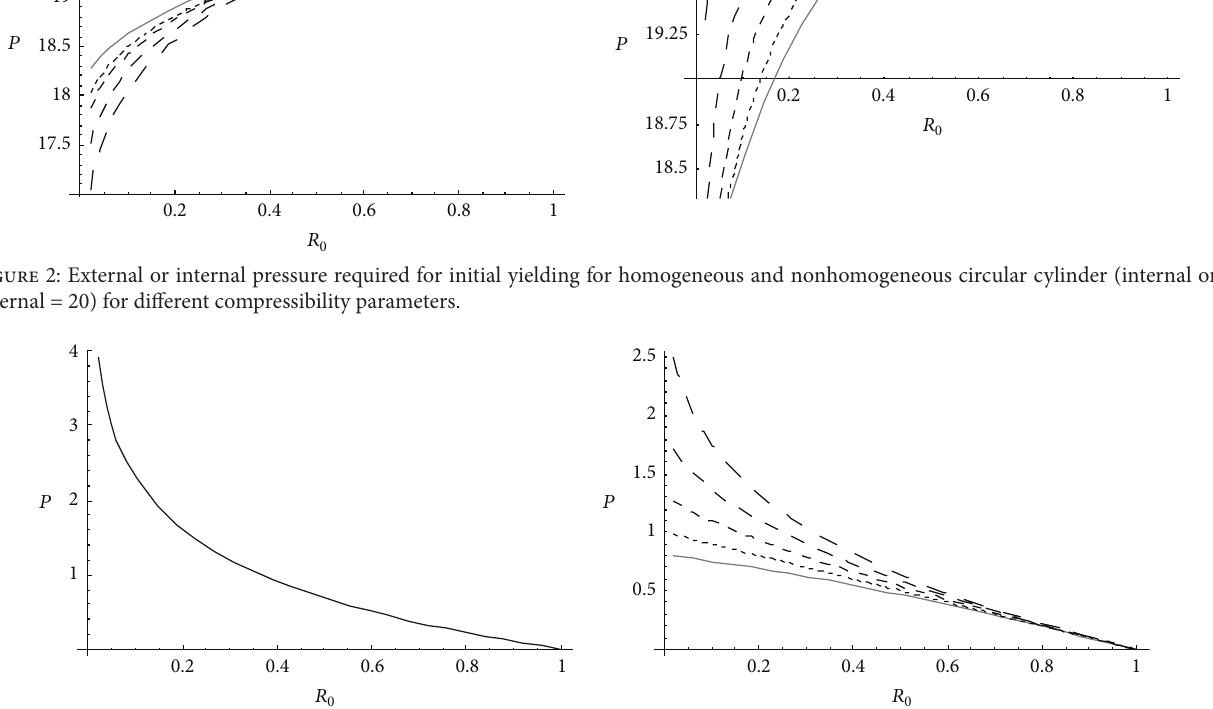
Figure 3: Effective pressure required for fully plastic state for homogeneous and nonhomogeneous circular cylinder for different compressibility